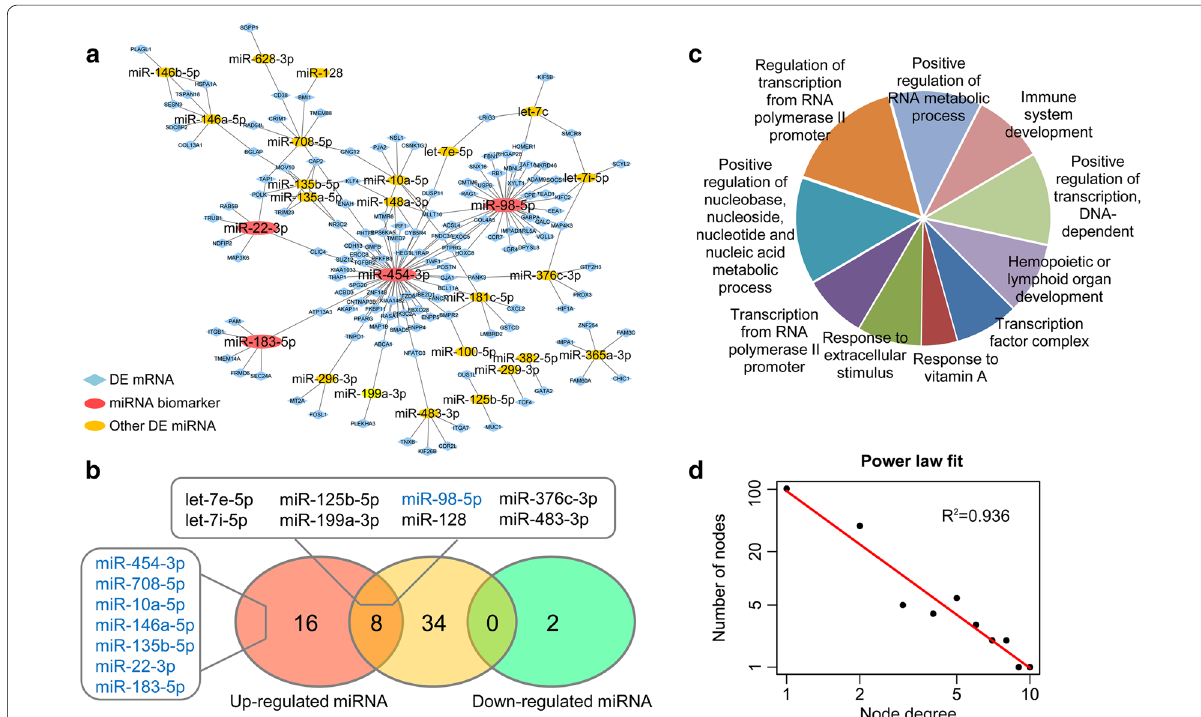
Fig. 1 Structural and functional characteristics of PRMNH. a Layout of PRMNH consisting of 190 regulations between 26 miRNAs and 140 mRNAs with differential expression patterns. b Intersection between known platinum resistance-associated miRNA biomarkers and up- or down-regulated miRNAs in PRMNH. The light red and green ellipses represent up-regulated and down-regulated miRNAs in PRMNH, respectively; light yellow ellipses represent known miRNA biomarkers involved in platinum resistance. miRNAs with properties of both hub and bottleneck nodes were highlighted with blue color. c Top 10 significantly enriched GO terms at the biological process level of miRNA target genes in PRMNH. The fan area represents the number of target genes implicated in the corresponding GO term. d Degree distribution of all nodes in